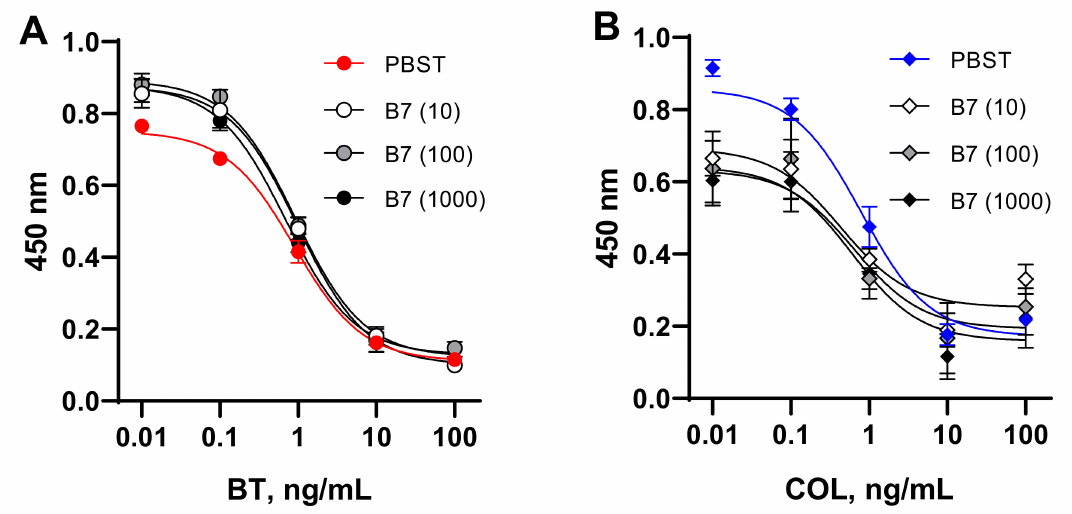
Figure 7. Standard curves for bacitracin ( A ) and colistin ( B ) determination in SAV–B 7- hapten ELISAs generated in PBST and buffer enriched with biotin (B 7 ) at 10, 100, and 1000